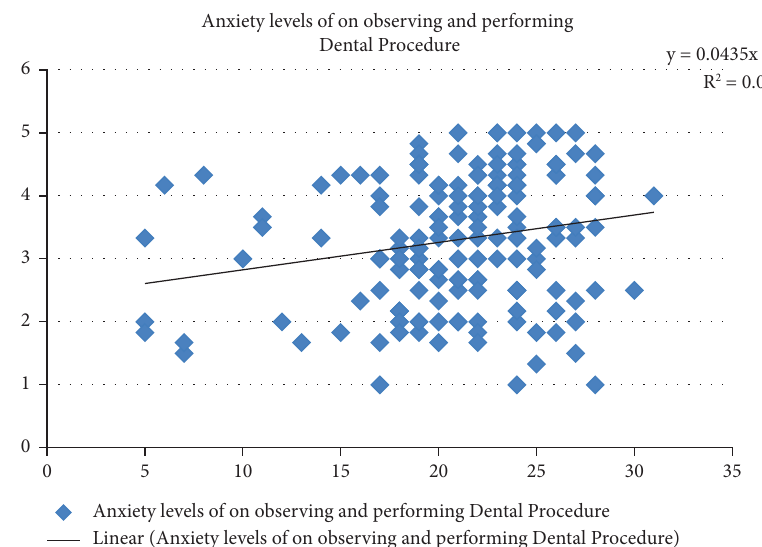
Figure 6: Association of COVID-19-related knowledge scores and anxiety level of the residents while observing and performing routine orthodontic procedures.